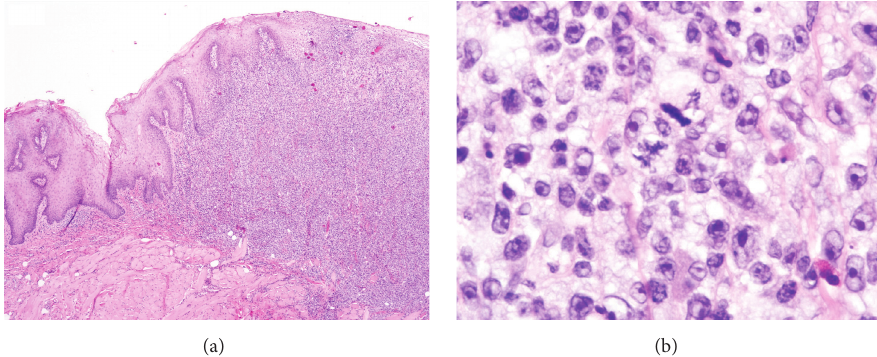
Figure 2: (a) Fungating lesion of the tongue shows a dense lymphoid infiltrate lined by the squamous epithelium of the oral mucosa. The infiltrate permeates into underlying skeletal muscle of tongue. Hematoxylin and eosin, × 40. (b) The infiltrate is composed of large cells with vesicular nuclei and prominent nucleoli. Atypical mitoses are also observed. Hematoxylin and eosin, × 1000.